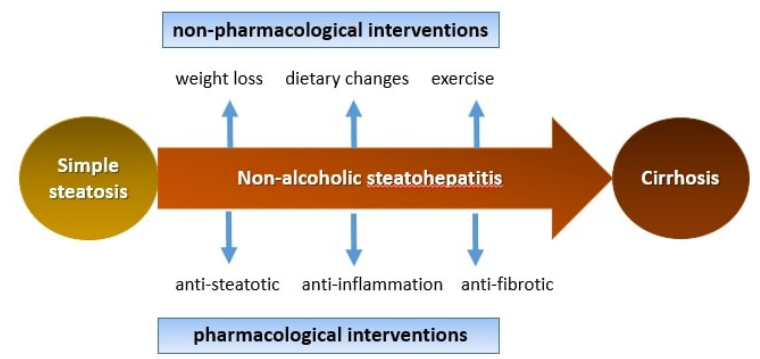
Figure 2. NASH treatment